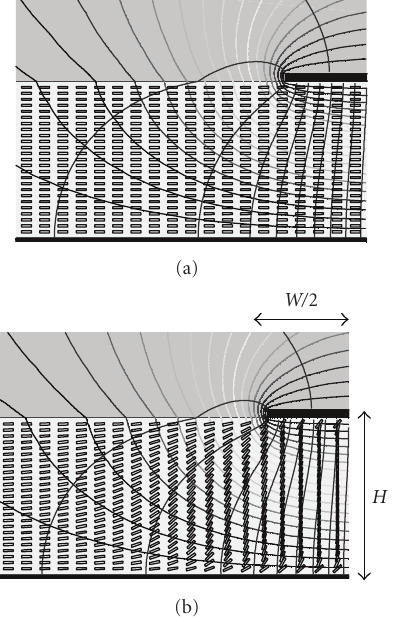
Figure 2: Director distribution by surface alignment without (a) and with a bias voltage on the upper electrode.